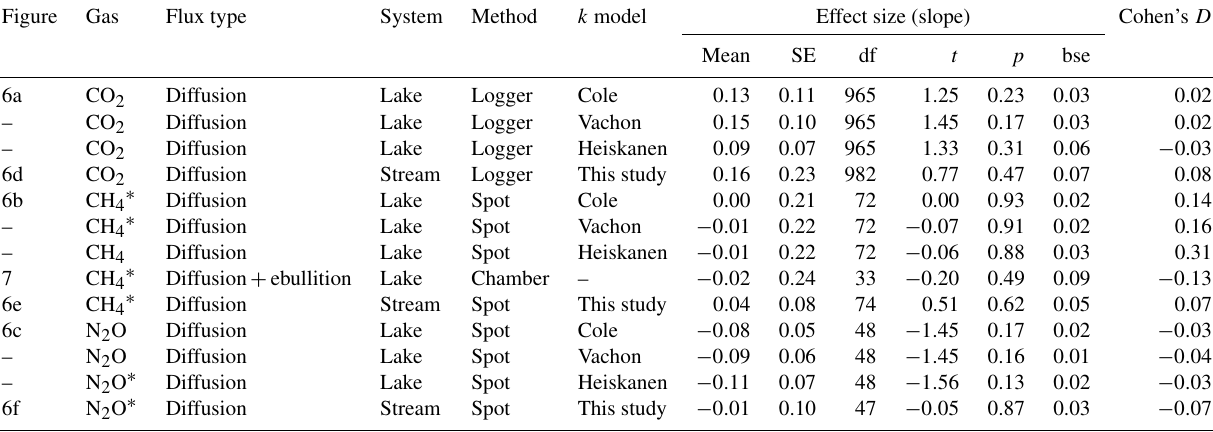
Table 4. Effect size of forest clear-cutting on fluxes of CO 2 , CH 4 , and N 2 O across the interface between lakes or streams and the atmosphere as shown in Figs. 6 and 7. Shown are linear mixed-effects model slope estimates, their standard errors (SEs), degrees of freedom (df), t and p values, and Cohen’ D , summarized as arithmetic means over ten bootstrap runs that take uncertainty from gap-filling and gas flux models into account (see Fig. S3). This uncertainty is expressed as bootstrap standard errors (bse) of p values. For lake–atmosphere fluxes, estimates based on three different k models are shown. Note that parameter estimates are based on log + n transformed data, where n is the smallest number that, when added, leads to positive normal values. Abbreviations: Logger is the daily mean of 2-hourly measurements, Chamber is the floating chamber, and Spot is the spot